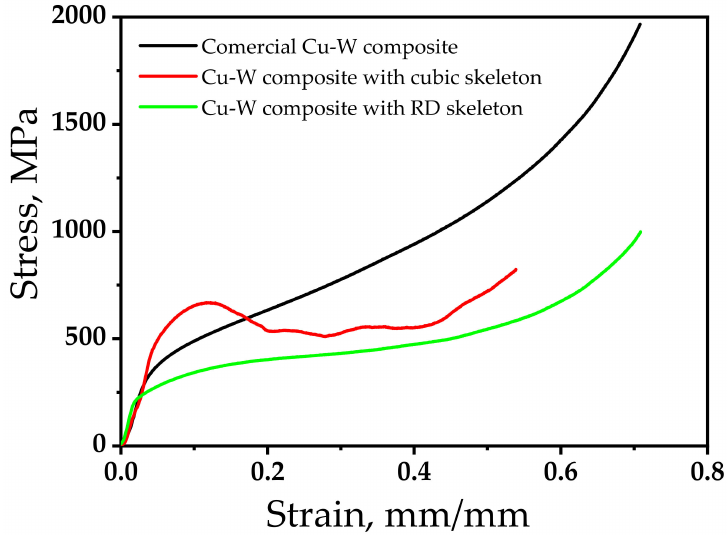
Figure 8. The engineering compressive stress–strain curves of the studied Cu-W composites with the cubic and rhombic dodecahedron (RD) W-skeletons and commercial Cu-W